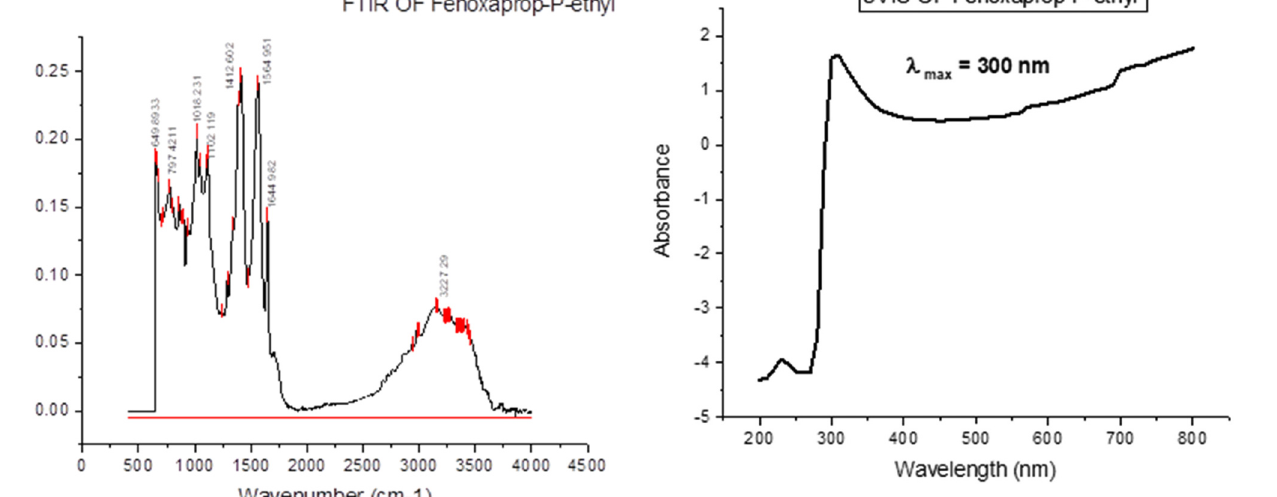
Figure 4: FT - IR results of fenoxaprop - p - ethyl.